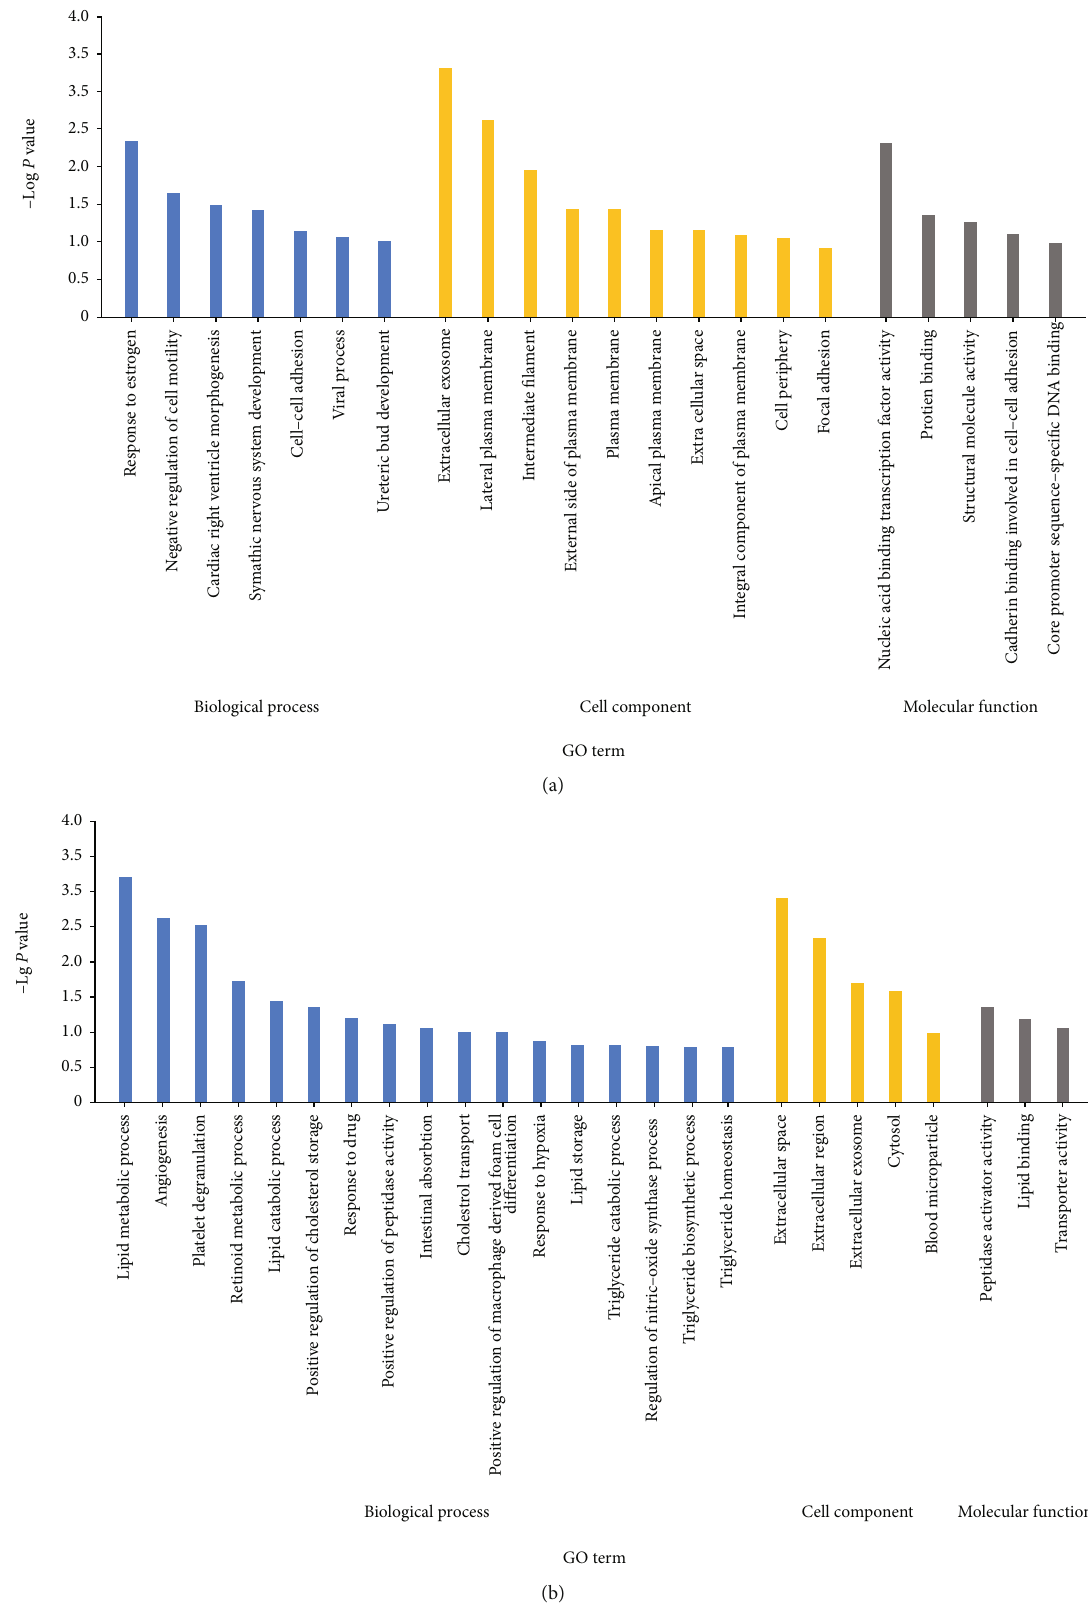
Figure 5: GO enrichment analysis of di ff erentially expressed genes ((a) upregulated genes and (b) downregulated gene; P < 0 : 05